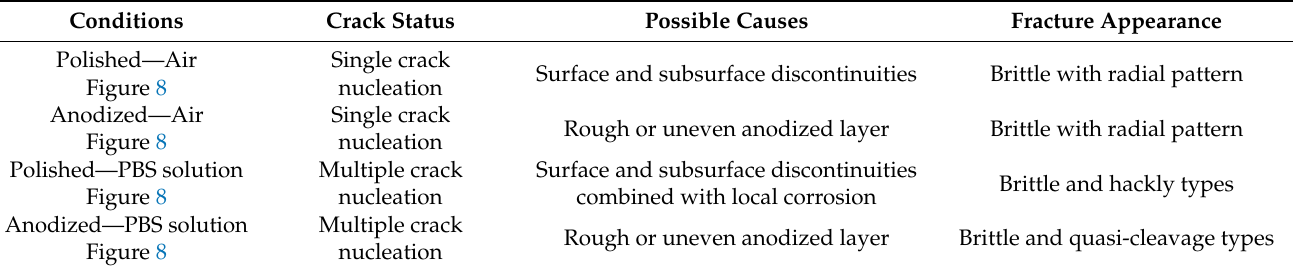
Figure 12. Fatigue fracture morphologies of the polished specimen tested in PBS solution at 140 MPa. The micrographs ( A – C ) correspond to the three different regions pointed out in the Figure 9c. Table 6. Summary of characteristics of the fractured specimens submitted to the corrosion fatigue